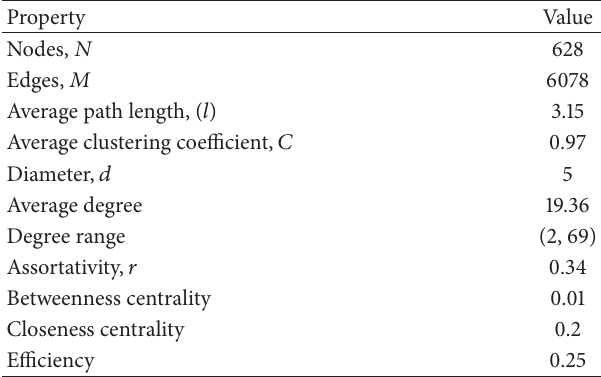
Table 1: Computed properties of Pakistan railways